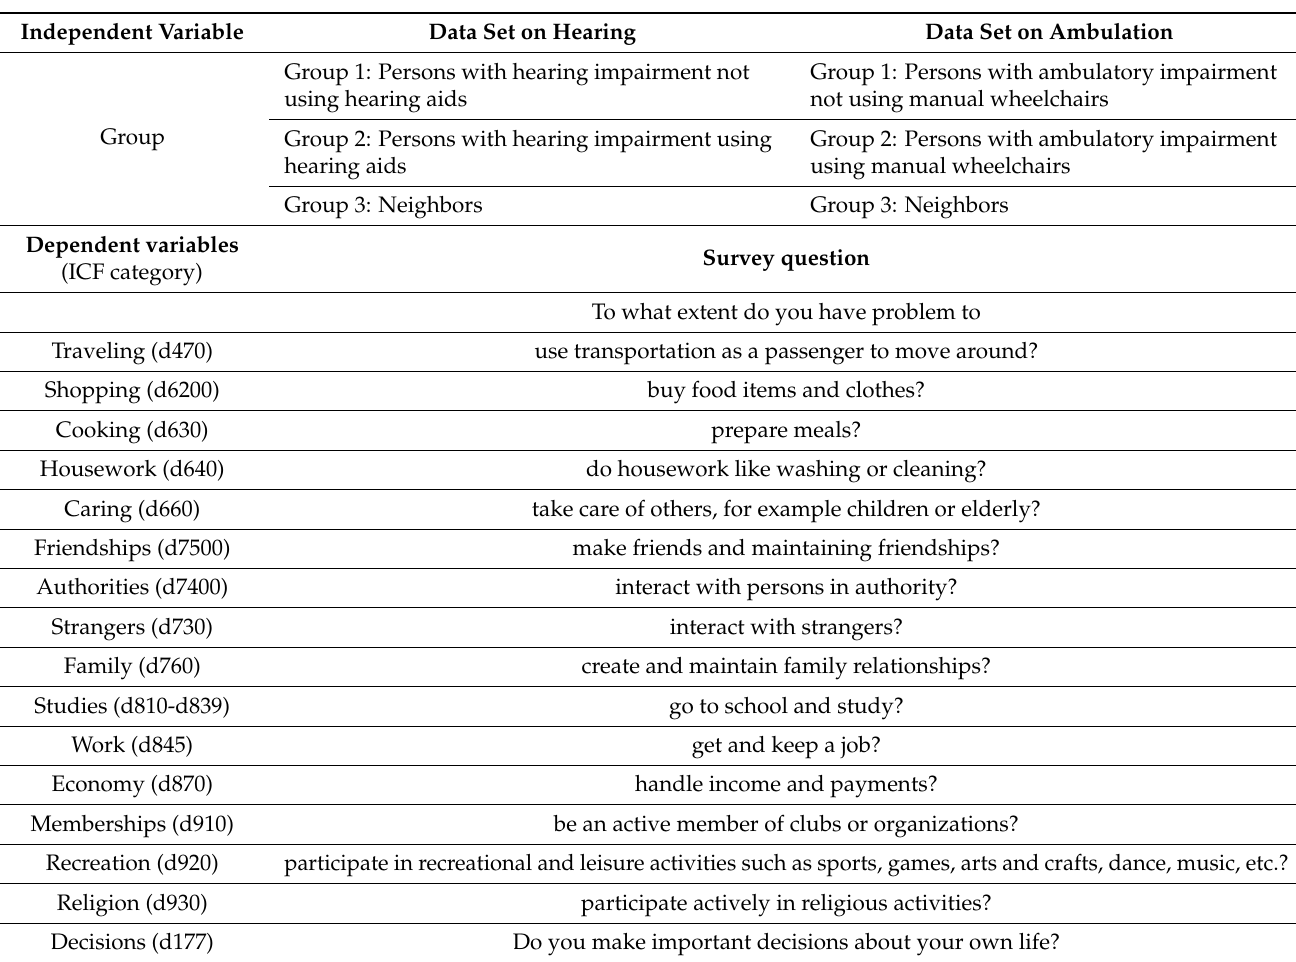
Table 1. Variables used in the analyses.